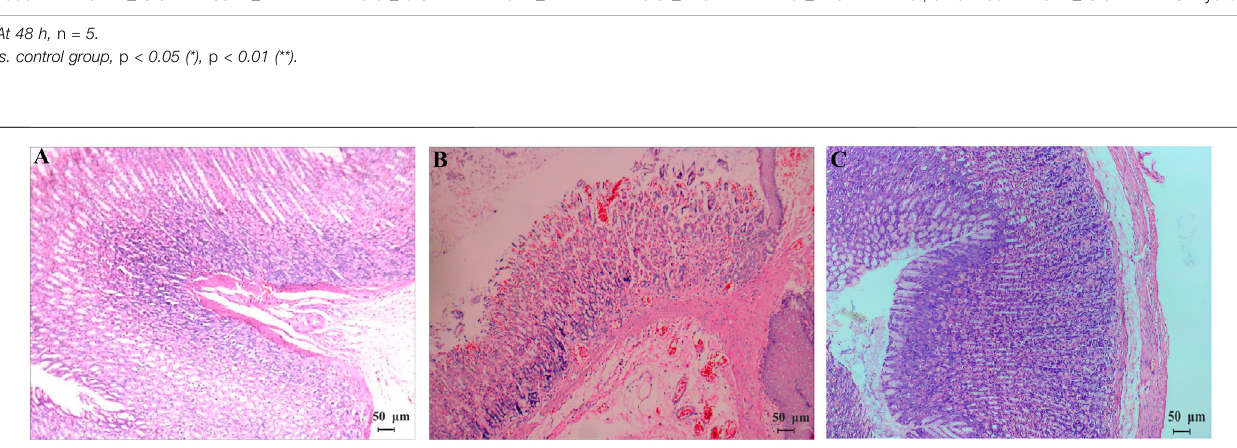
Frontiers in Pharmacology |